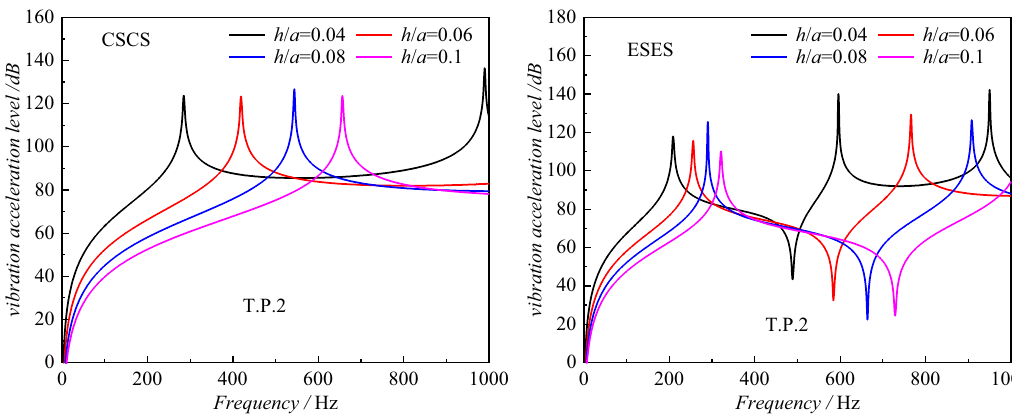
Figure 11: Comparison of the steady vibration of rectangular plate with di ff erent h / a ratios.